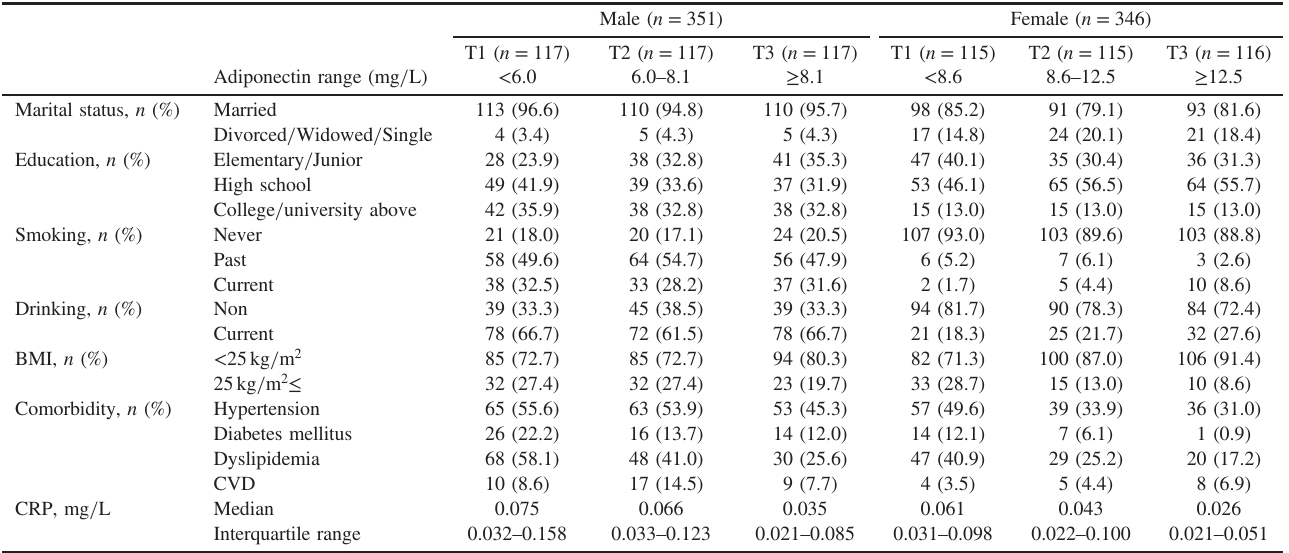
Table 1. Baseline characteristics by